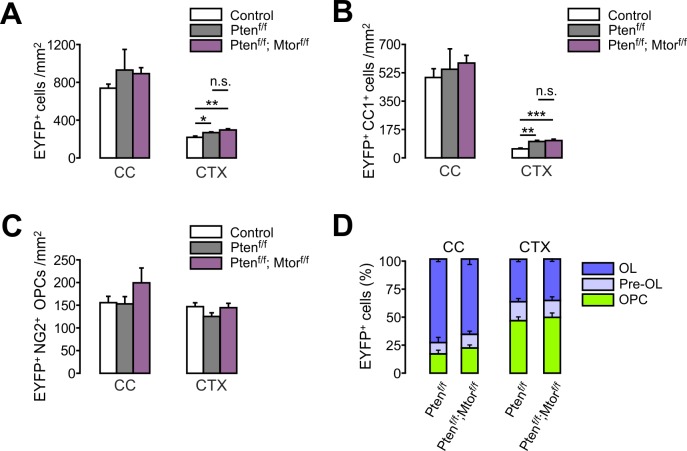
Additional Mtor ablation does not reverse Pten-ablation-induced oligodendrocyte promotion in the brain.(A) Quantification of EYFP+ cells in the control (Pdgfra-CreER; R26-EYFP), Pten cKO, and Pten-Mtor double cKO mice (P20 +21). (B, C) Quantification of EYFP+CC1+ OLs (B) and EYFP+NG2+ OPCs (C). (D) Percentages of OPC, pre-OL, and OL among EYFP-labeled cells. Data are represented as mean ±S.E.M. n = 4 (control and Pten-Mtor double cKO) or 5 (Pten cKO) mice. One-way ANOVA with Bonferroni post hoc test for (A - C), and unpaired Student's t-test for (D). The numerical data for the graphs are available in Figure 7—figure supplement 1—source data 1.10.7554/eLife.32021.026Figure 7—figure supplement 1—source data 1.Numerical data for graphs in Figure 7—figure supplement 1.